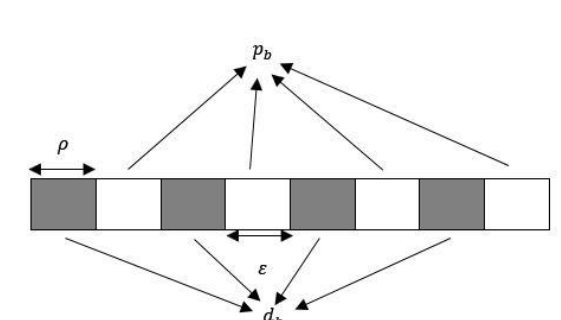
Fig. 1. GFDM Transmitter